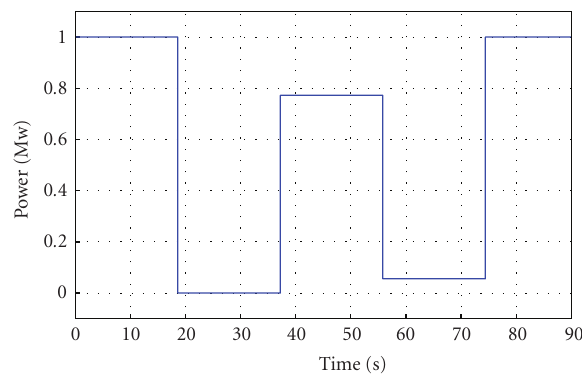
Figure 14: Wind speed.